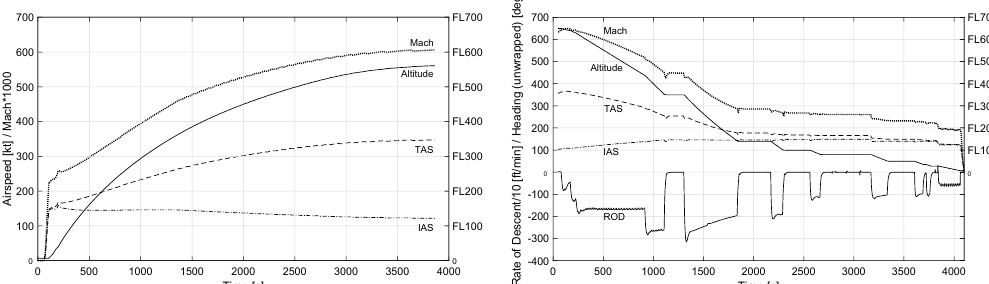
Figure 12. Simulated RQ-4A climb/speed profile of a surveillance mission over the North Pole and descent profile back into Oslo-Gardermoen. Table 6. Global Hawk climb time for the real and simulated RQ-4A. Climb